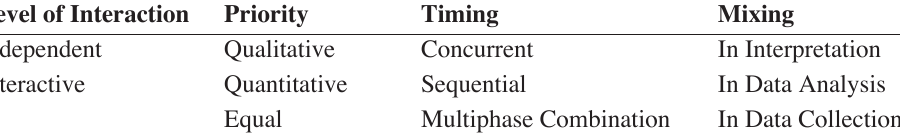
Table 2. Key Decisions in